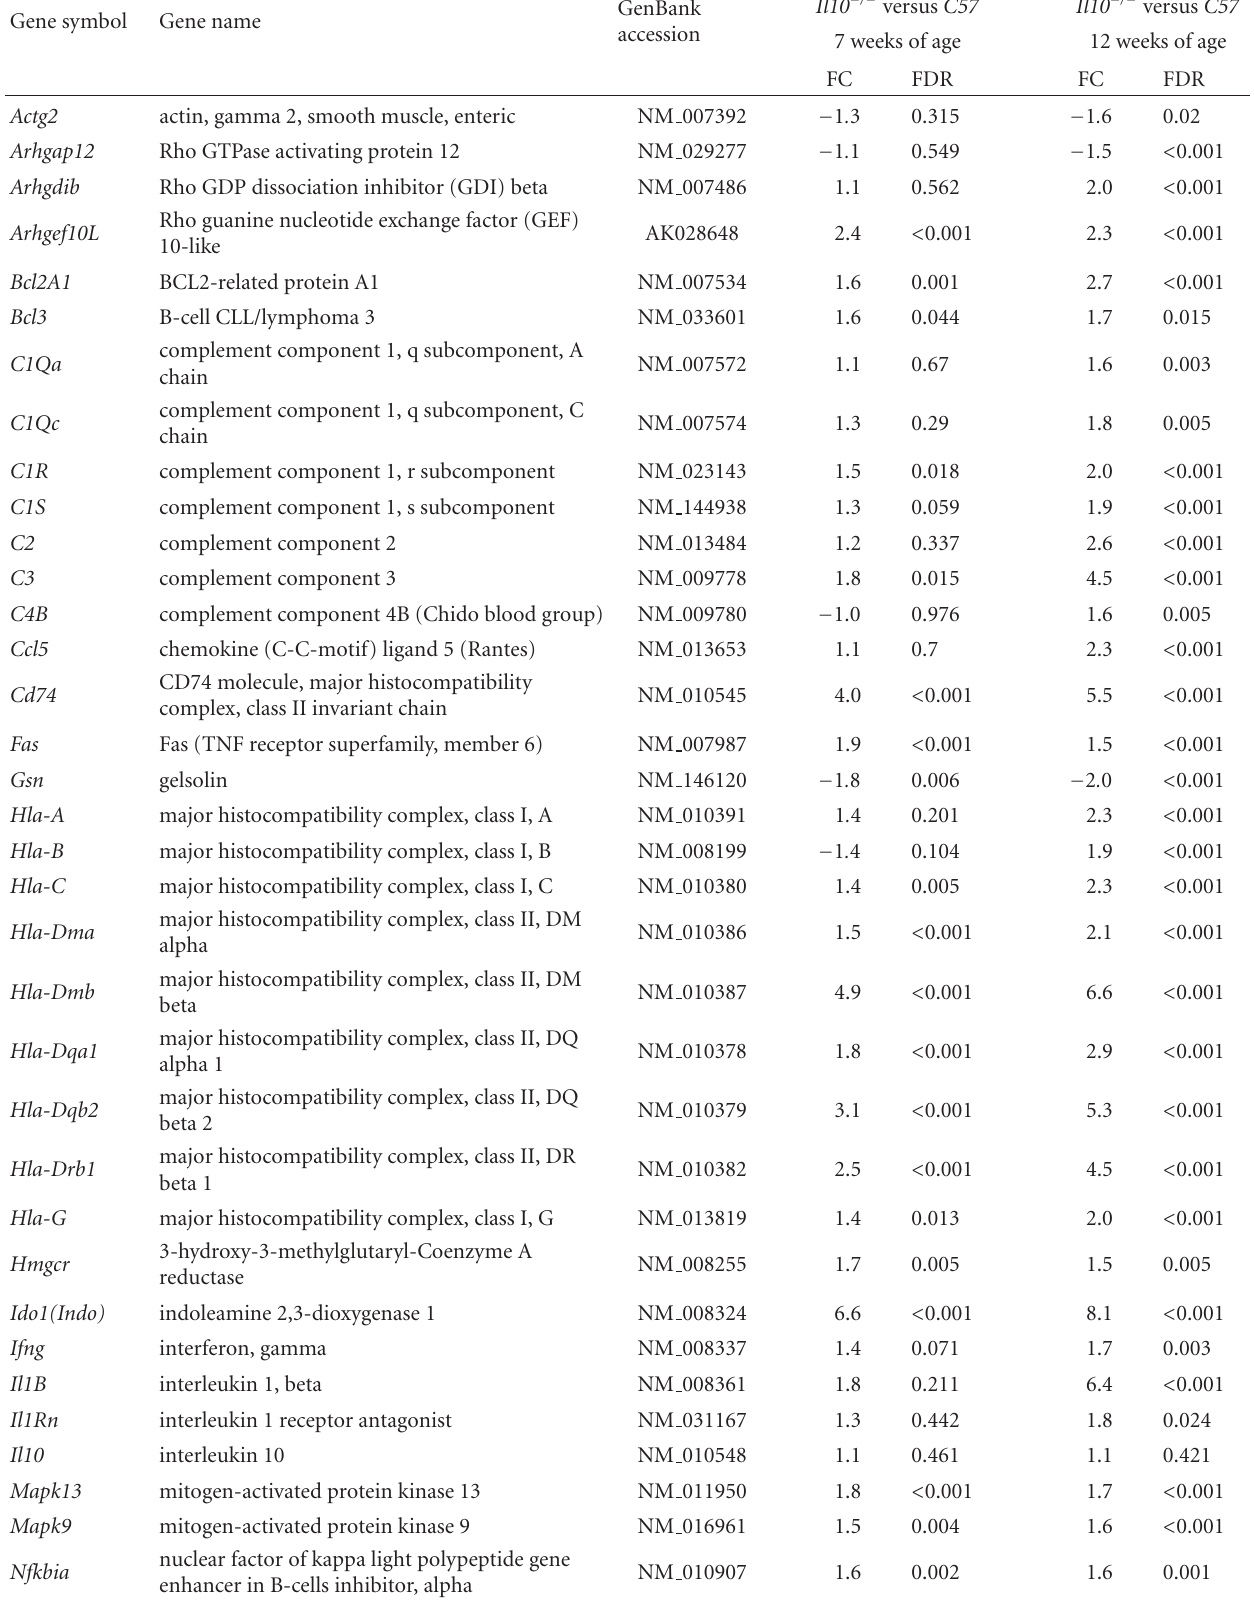
Table 7: Di ff erentially expressed genes in the colon of Il10 − / − mice compared to C57 mice at 7 and 12 weeks of age. Gene